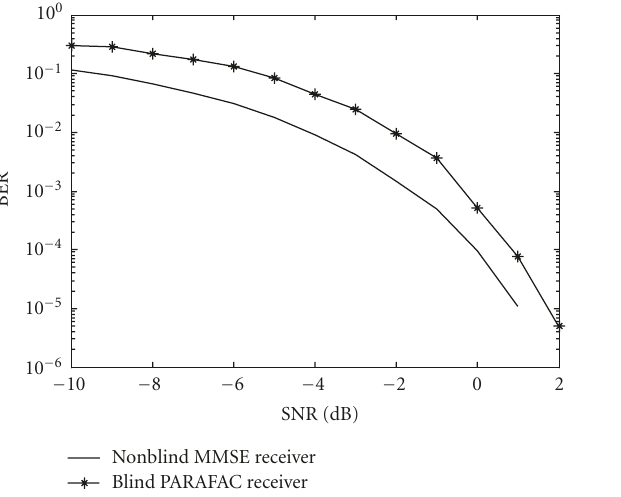
Figure 2: The algorithm performances comparison with N = 800.